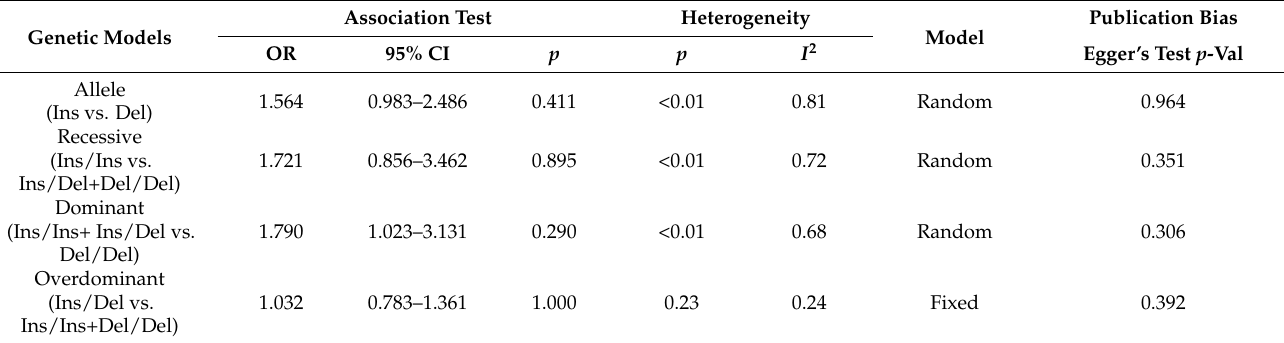
Table 2. Overall analysis between HLA-G polymorphism (14-bp insertion/deletion (rs16375)) and susceptibility to acute rejection in kidney transplant recipients.